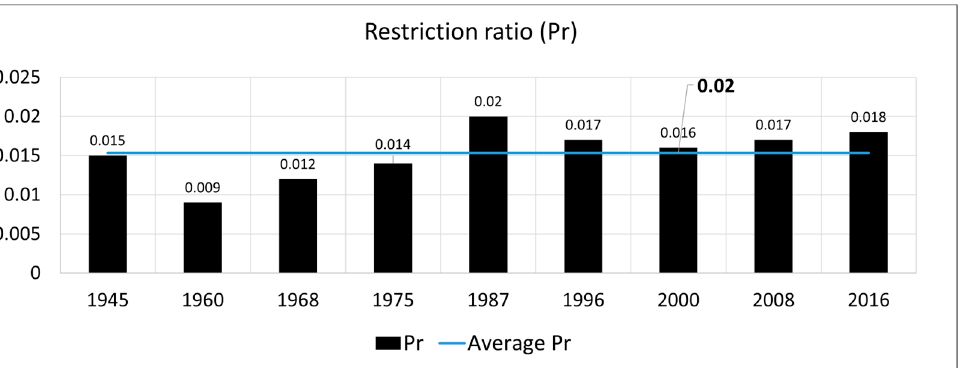
Figure 4. Kotychi Lagoon restriction ratio (Pr) index fluctuations during the study period. The blue line represents the average Pr